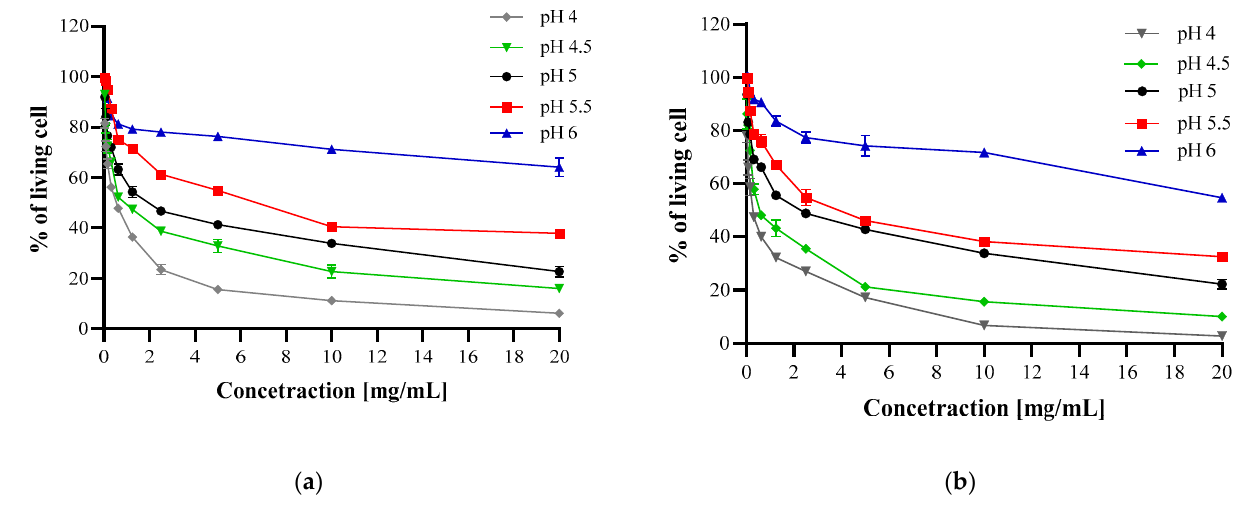
Figure 5. Antibacterial properties of CH ( a ) or CH_LA ( b ) against E. coli at different pH levels.